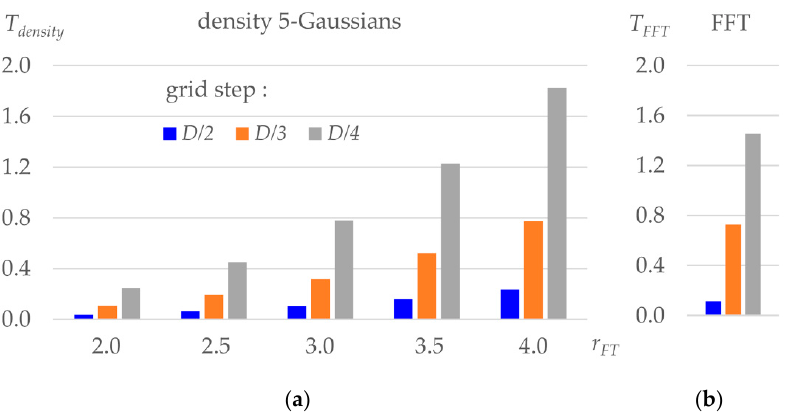
Figure 4. CPU time for the three-step map calculation for different grid steps expressed as a part of the resolution D . ( a ) CPU time, in seconds, to calculate a density distribution for the test protein model using different truncation distance r FT . ( b ) CPU time to calculate FFT on a grid as defined in ( a ).